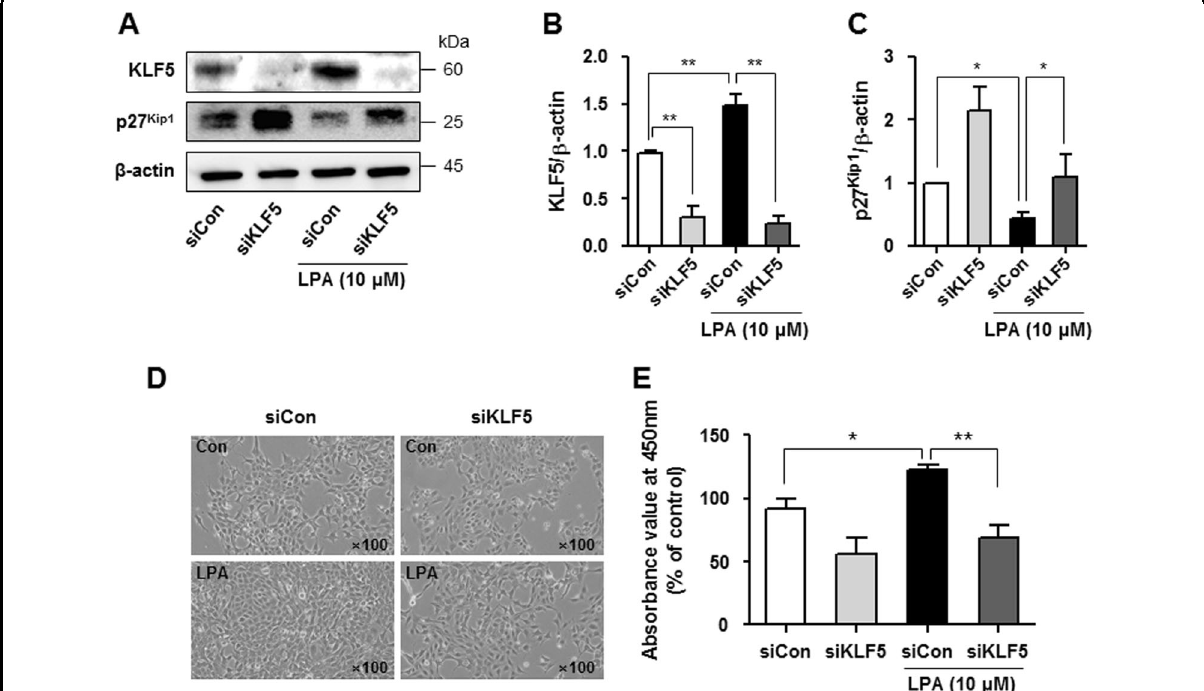
Fig. 4 Downregulation of KLF5 inhibits the LPA-induced proliferation of SV40 MES13 cells. a Cells were transfected with a scrambled siRNA (siCon) or KLF5 siRNA (siKLF5) for 48 h and treated with LPA (10 μ M) for 6 h, and the levels of the KLF5 and p27 Kip1 proteins were determined using western blotting. b , c The relative levels of the proteins were normalized to β -actin and quanti fi ed using ImageJ software ( n = 3 independent experiments). d Cell morphology was examined using light microscopy (original magni fi cation, × 100), and ( e ) cell proliferation was analyzed using CCK-8 assay after treatment with 10 μ M LPA and transfection of the KLF5 siRNA or scrambled siRNA for 24 h ( n = 3 independent experiments). * p < 0.05, ** p < 0.01. Data are presented as means ±